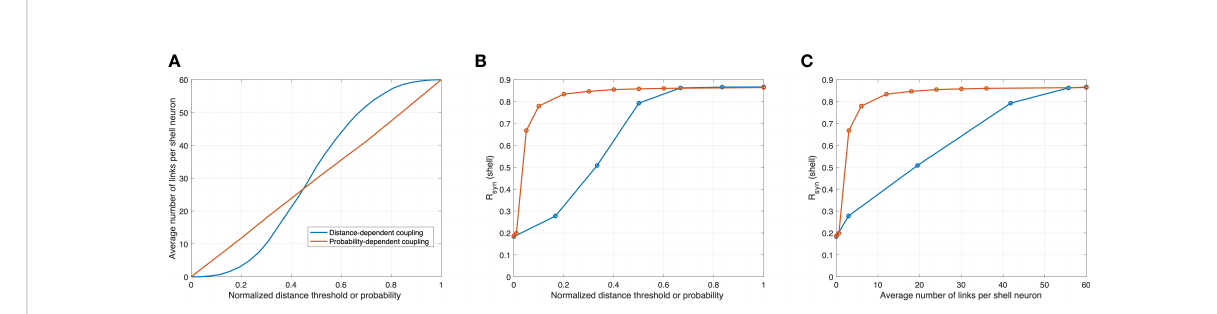
Correlations between synchronization in the shell, normalized distance threshold D PT D in the distance-dependent model, probability P PT in the PT , max probability-dependent model, and the average number of links per shell neuron. Orange and blue curves are modeled with distance-dependent and probability-dependent networks, respectively. (A) as probability increases, the average connection rises linearly in the probability-dependent network, while as the distance threshold increases, the average connection rises in a sigmoid fashion. (B) and (C) in the probability-dependent network, the synchronization level increases rapidly as functions of probability and average connections, while this increase is more graduate in the distance-dependent